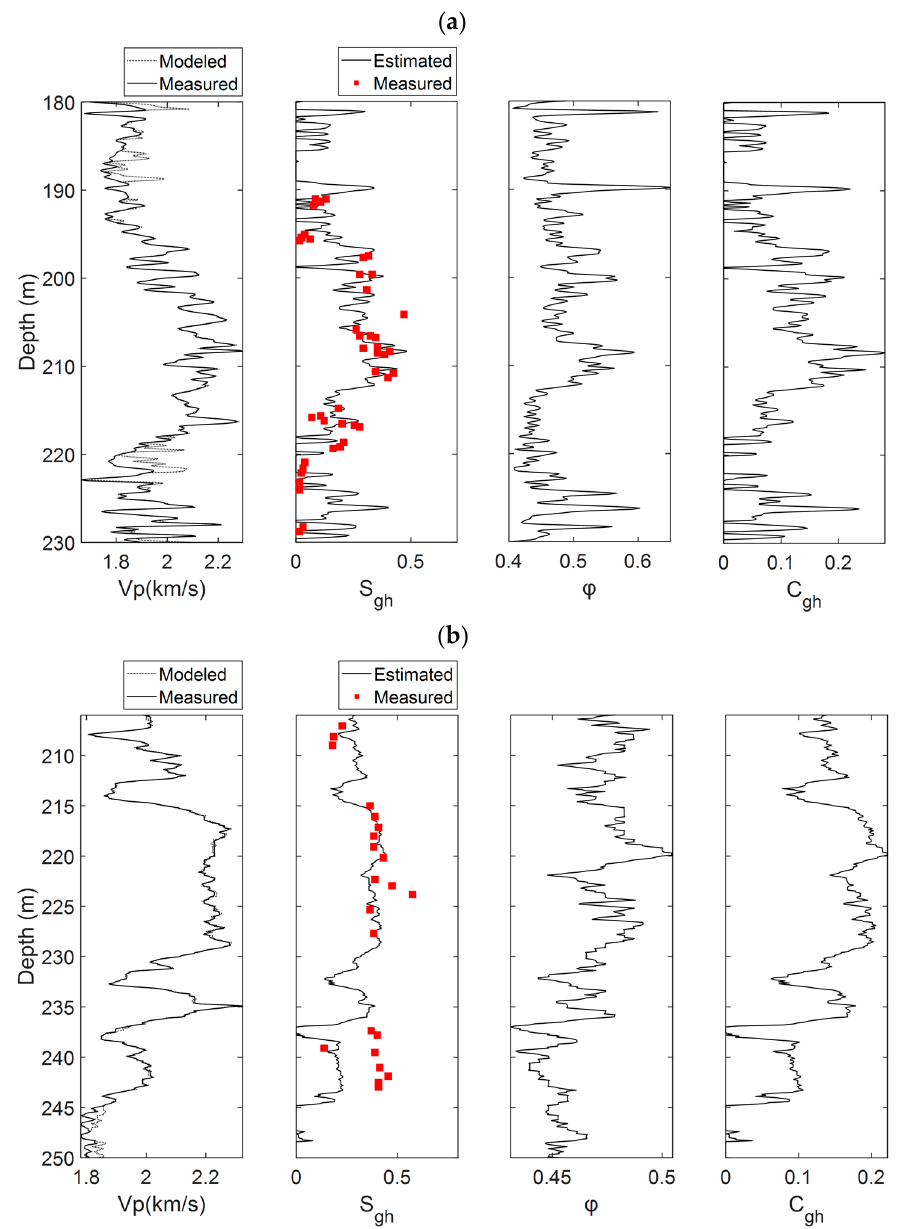
Figure 11. Estimated results in ( a ) SH2 and ( b ) SH17 wells, including the V P log overlaid by mod-